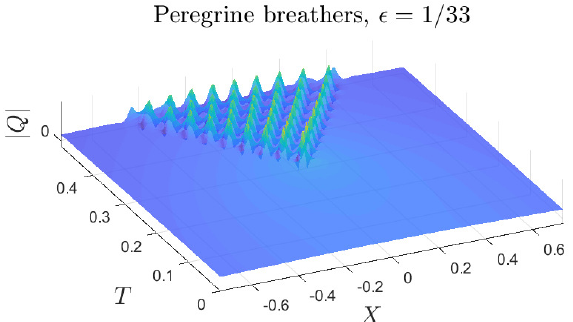
Figure 7. Case 3: A family of Peregrine breathers generated from the initial condition (13) when (cid:101) = 1/33, γ = 1, M = 1 and ∆ = 0.